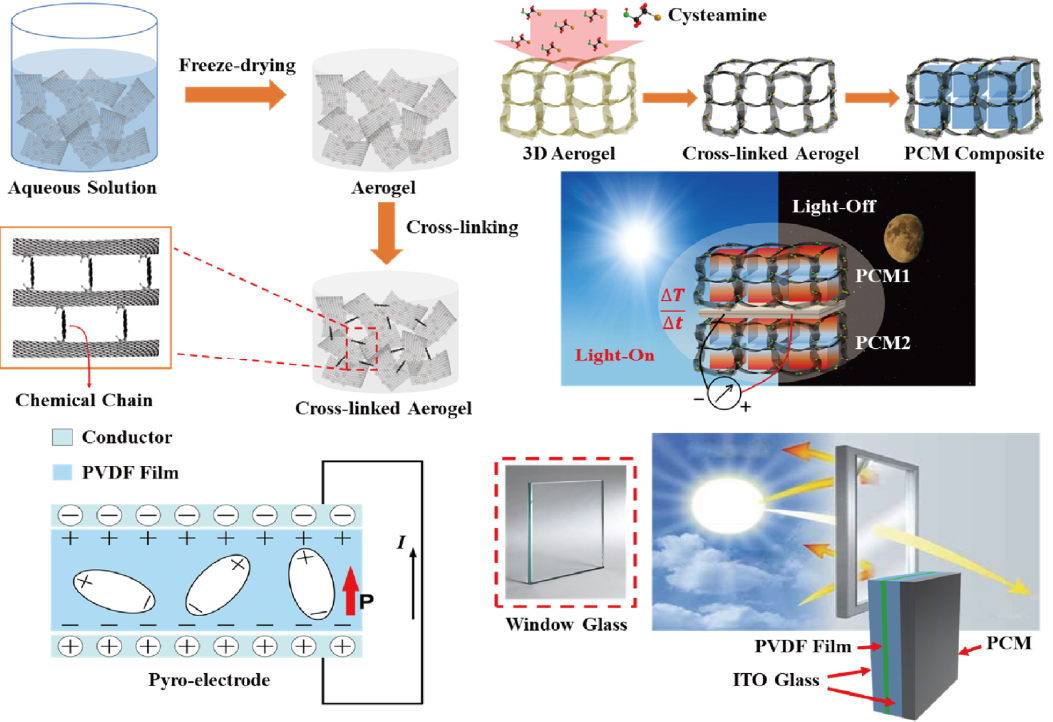
Figure 1. Schematic of the fabrication of cross-linked graphene aerogel by the cysteamine vapor method. The graphene/cysteamine aerogel (GCA)-supported phase change material (PCM) compo-